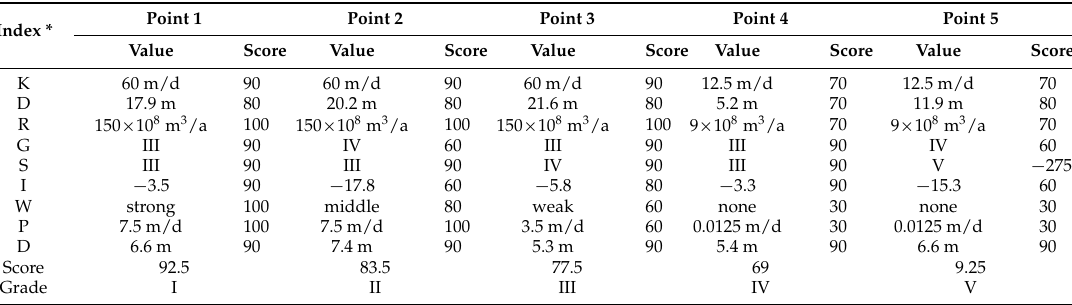
Table 12. All single index values and scores for five typical